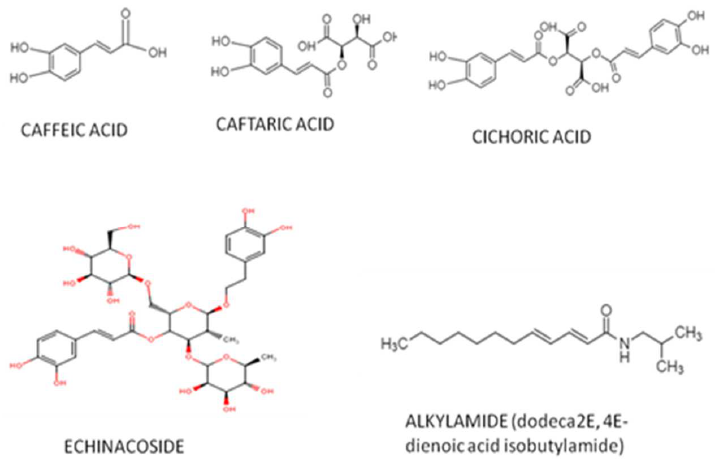
Figure 4. Structure of major compounds.